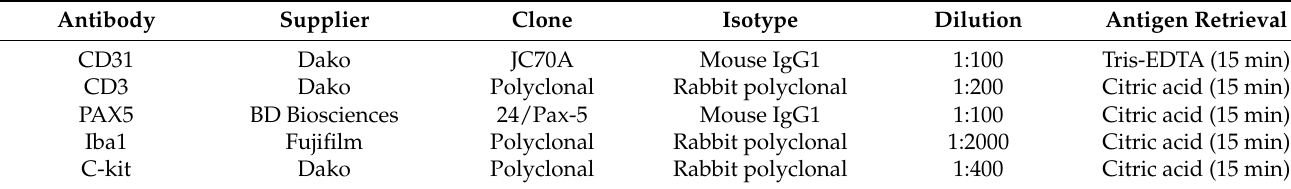
Table 1. Primary antibodies and immunohistochemical staining